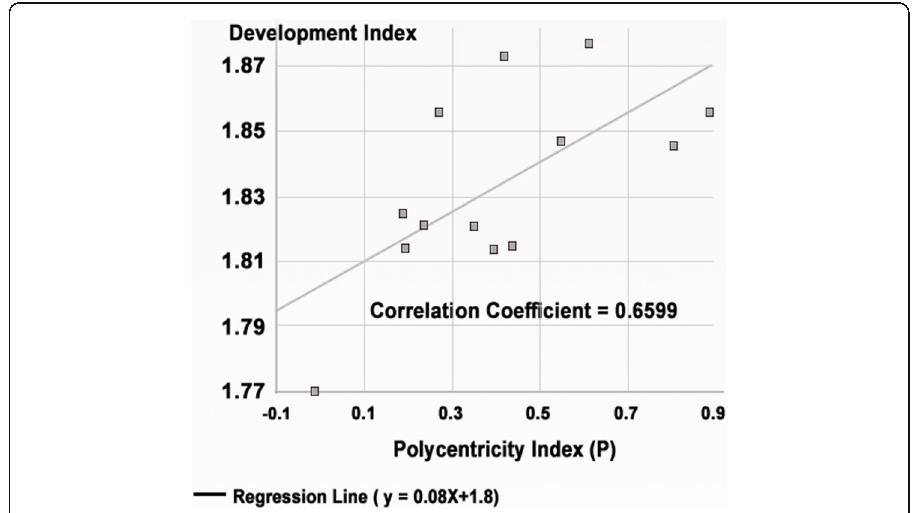
Fig. 2 The relationship between the polycentricity index and the development index for selected 13 European